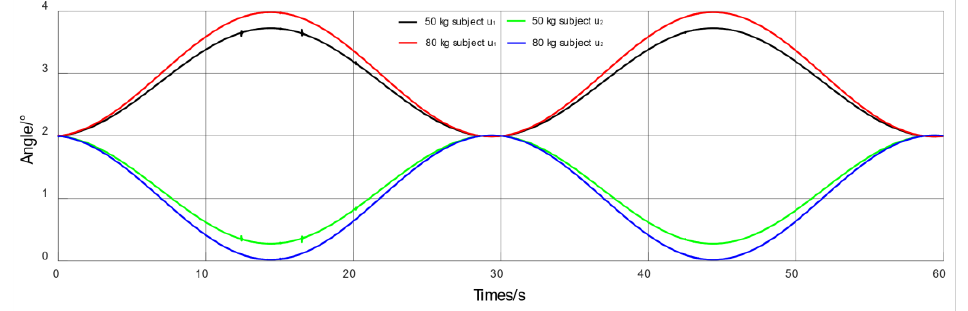
Figure 6. Proportional valve control voltage .